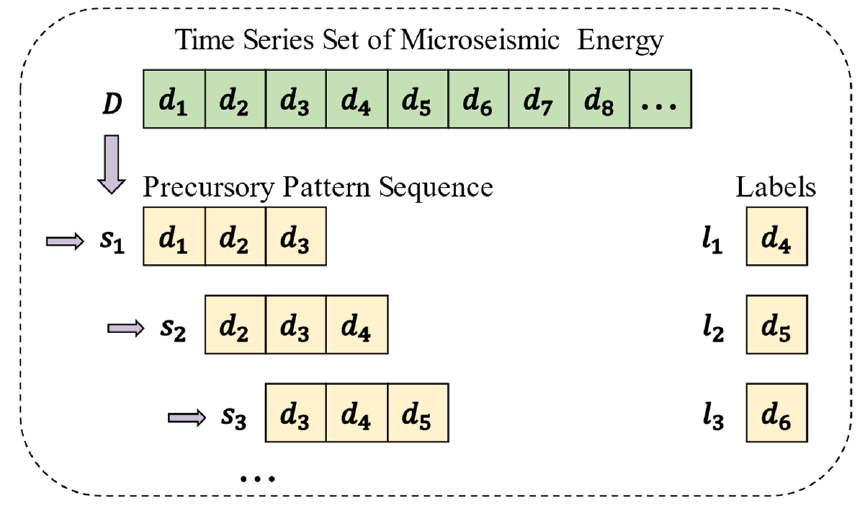
Figure 14. The workflow of microseism energy data processing.